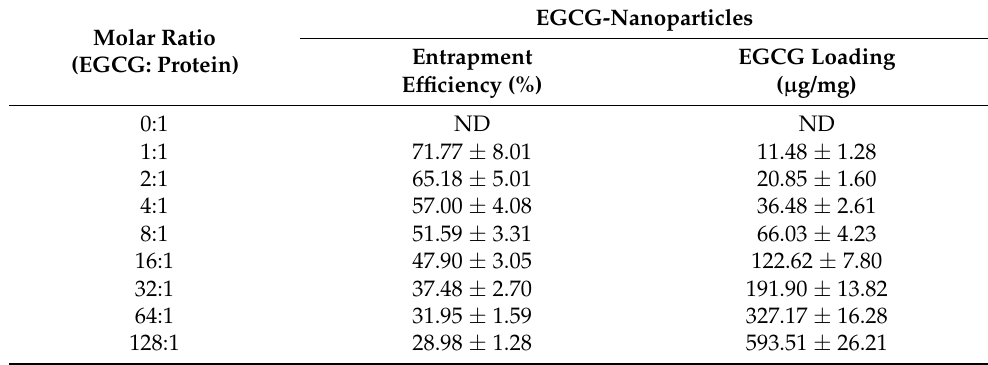
Table 2. Effect of EGCG/lysozyme molar ratio (1:1) on EGCG loading onto EGCG-nanoparticles and entrapment efficiency of